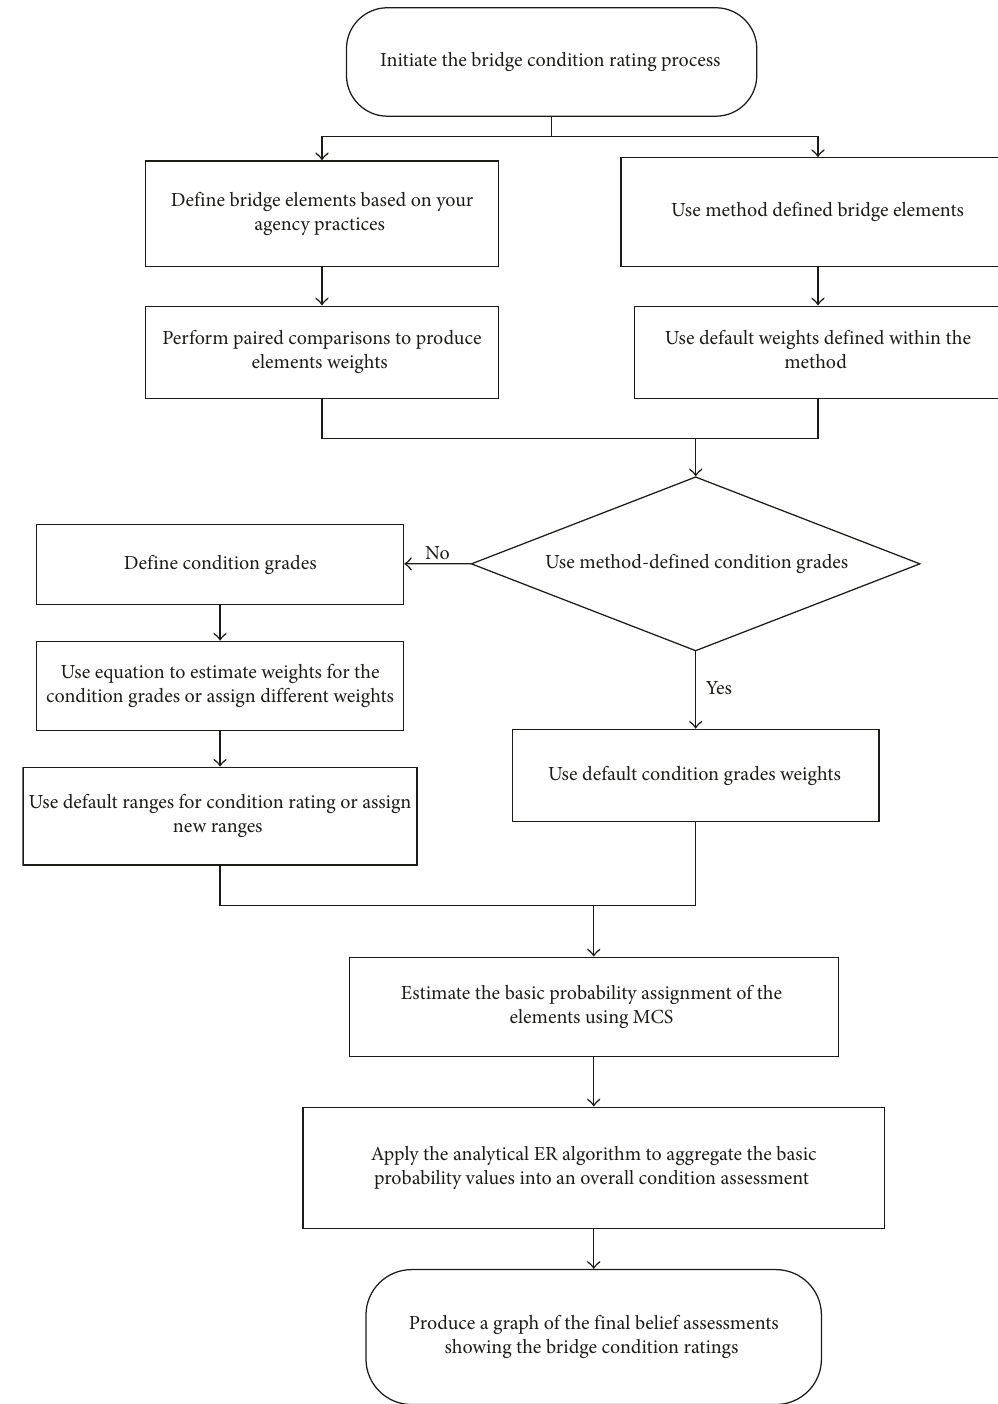
Figure 1: Flowchart for the condition assessment and rating method of concrete